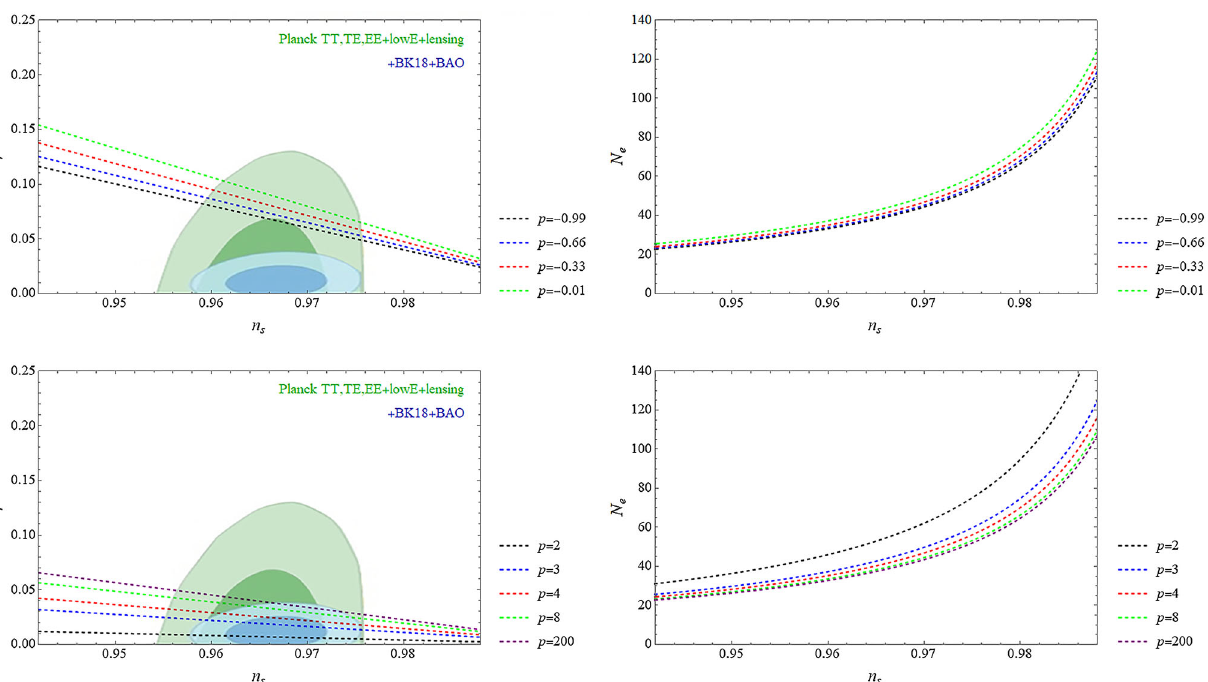
Fig. 1 Plots of r ( n s ) and N e ( n s ) for V 0 σ ( n = 1) with V 0 > 0 (top plots) and V 0 < 0 (bottom plots). In left plots, green and blue regions are related to the Planck 2018 data [33] and its combination with BK18 and BAO [34], respectively. In addition, the 68% confidence regions are distinguished from the 95% confidence regions by highlighting the cor- responding regions. Depending on the values of p , the curves of r ( n s )